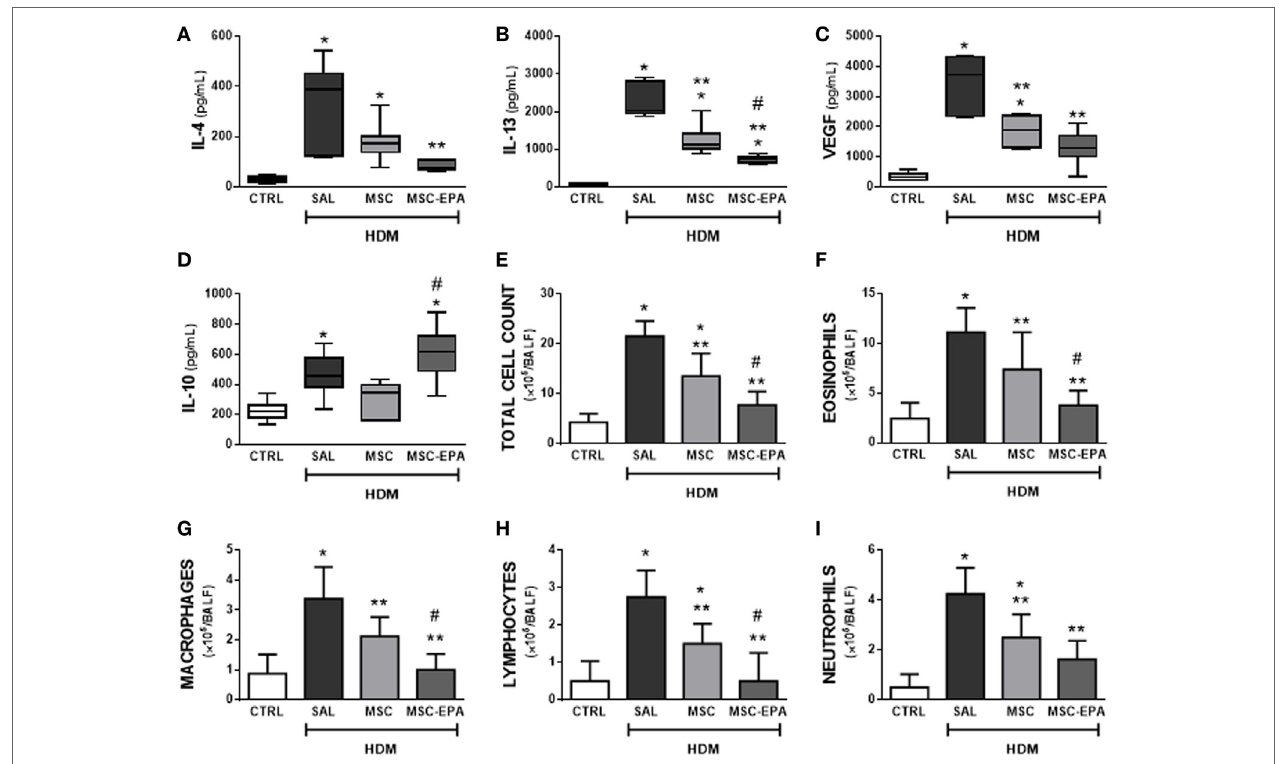
FigUre 2 | EPA-stimulated MSCs led to greater modulation of biomarker secretion and reduction in bronchoalveolar lavage fluid (BALF) cellularity than unstimulated MSCs. Protein levels of (a) IL-4, (B) IL-13, (c) VEGF, (D) IL-10, (e) total leukocytes, (F) eosinophils, (g) macrophages, (h) lymphocytes, and (i) neutrophil counts in BALF. CTRL, saline-challenged mice; HDM, HDM-challenged mice; SAL, HDM mice treated with saline; MSC, HDM mice treated with unstimulated MSCs; MSC-EPA, HDM mice treated with EPA-stimulated MSCs. Kruskal–Wallis test followed by Dunn’s test (a–D) and one-way ANOVA followed by Tukey’s test (e–i) were used for statistical comparison. (a–D) Boxes show the interquartile (25–75%) range, whiskers denote the range (minimum–maximum), and horizontal lines represent the median of eight animals/group. (e–g) Data presented as mean + SD of eight animals/group. *Significantly different from CTRL ( p < 0.05). **Significantly different from HDM-SAL ( p < 0.05). # Significantly different from HDM-MSC ( p < 0.05). Abbreviations: EPA, eicosapentaenoic acid; MSCs, mesenchymal stromal cells; HDM, house dust mite; IL, interleukin; VEGF, vascular endothelial growth